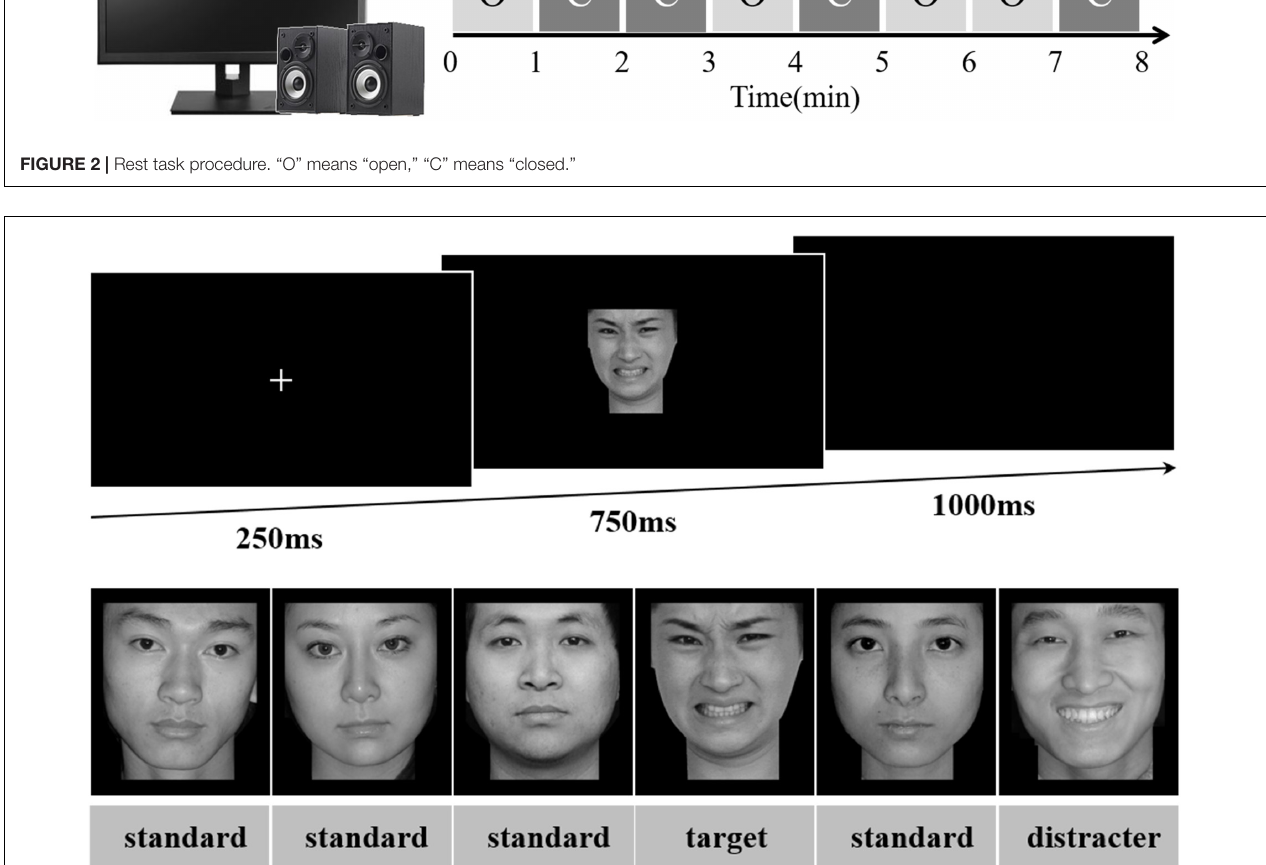
FIGURE 3 | Oddball task. A single trial of the oddball task is shown, with the fixation, stimulus, and blank screen sequence depicted. A sequence of stimuli that could be presented is shown with trial-type labels added in the figure for easier identification. This sequence would be within a block in which negative faces served as targets. Source for the photos: the Chinese Face Affective Picture